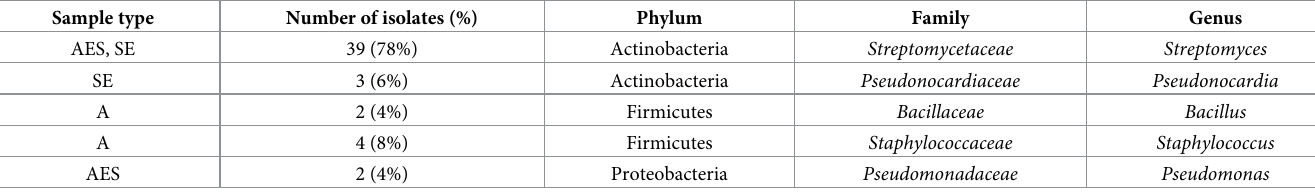
Table 2. 16S rRNA gene-based identification of bacteria isolated from lagoons Morrope and Bayovar. Sample